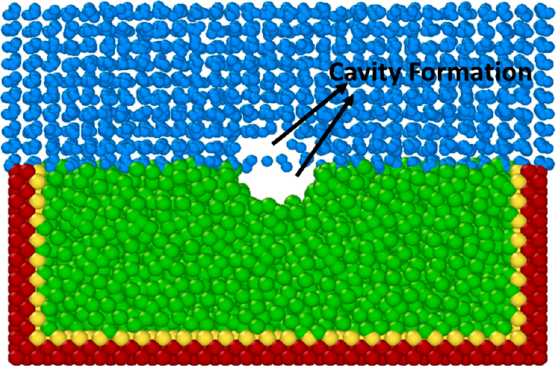
Figure 16. MD Simulation Snapshot Showing the Formation of Cavities Leading to Bubble Formation